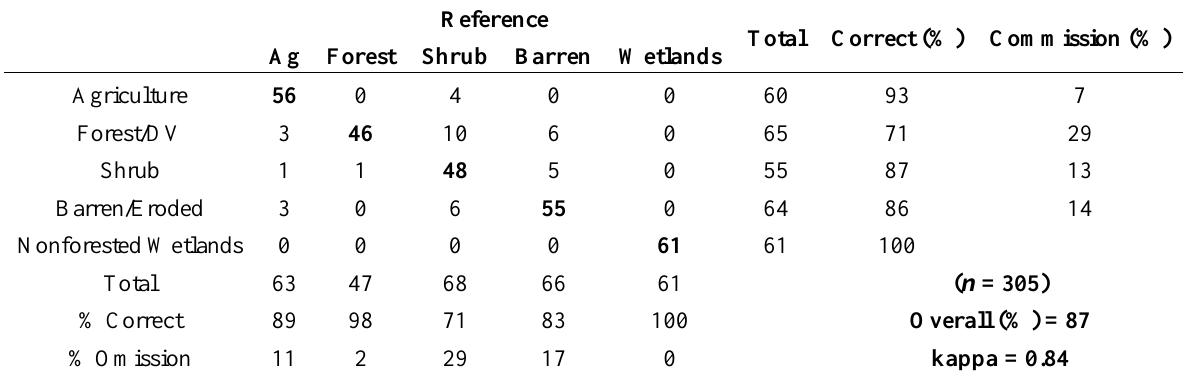
Table 1. Accuracy assessment for 2010 image